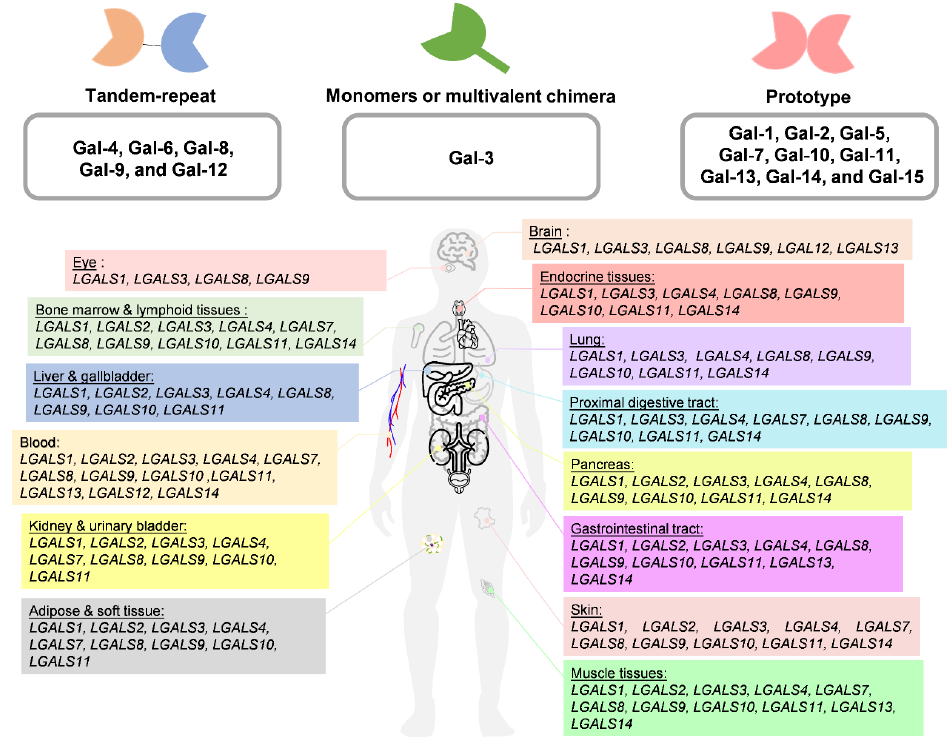
Figure 1. ( A ) The groups of Gal’s family structures. ( B ) The distribution of galectin ( LGALS ) is dependent on the RNA level in the human body. All profiles were collected from the human protein atlas website (https://www.proteinatlas.org/